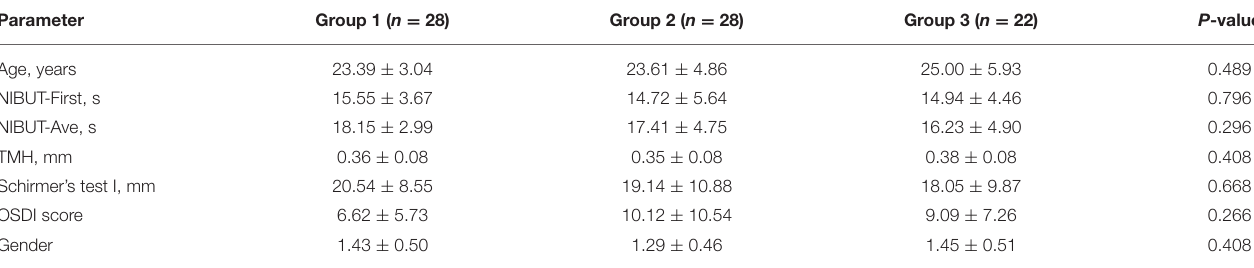
TABLE 1 | Clinical parameters of patients before refractive surgery.